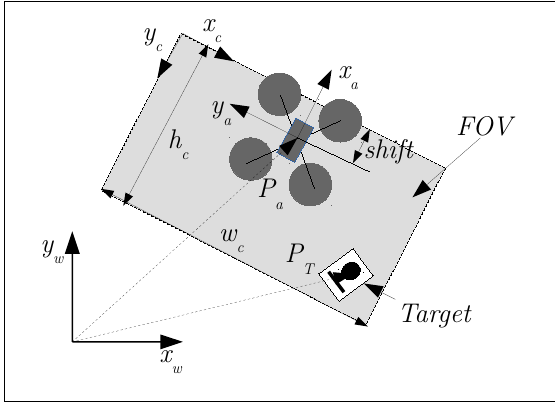
Figure 4. Field of view parameters for the UAV onboard camera, target and world frames.